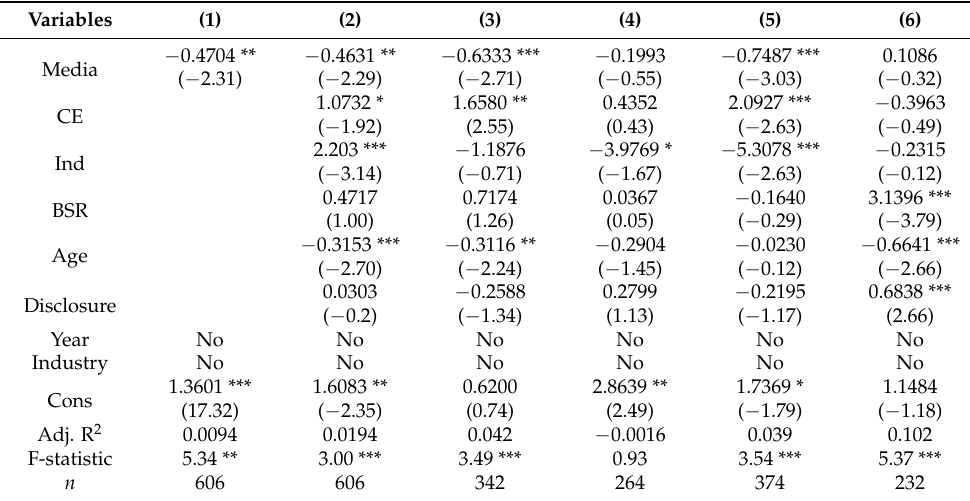
Table 6. Media attention and the return of corporate environmental